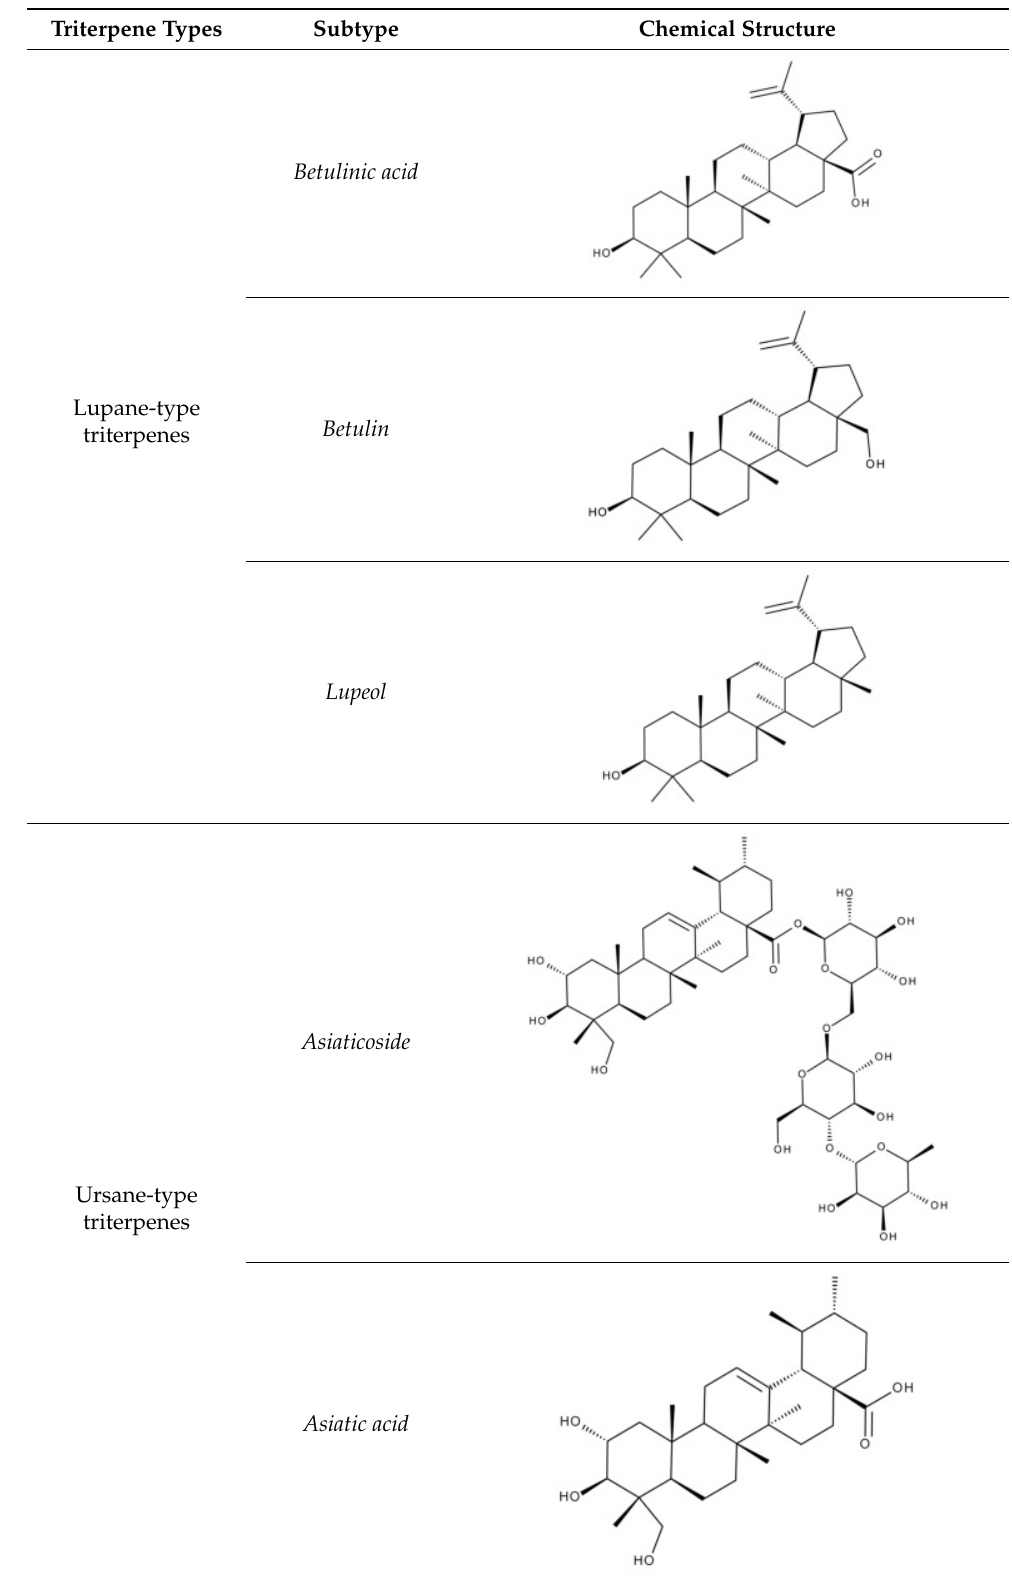
Table 5. The chemical structure of the most representative